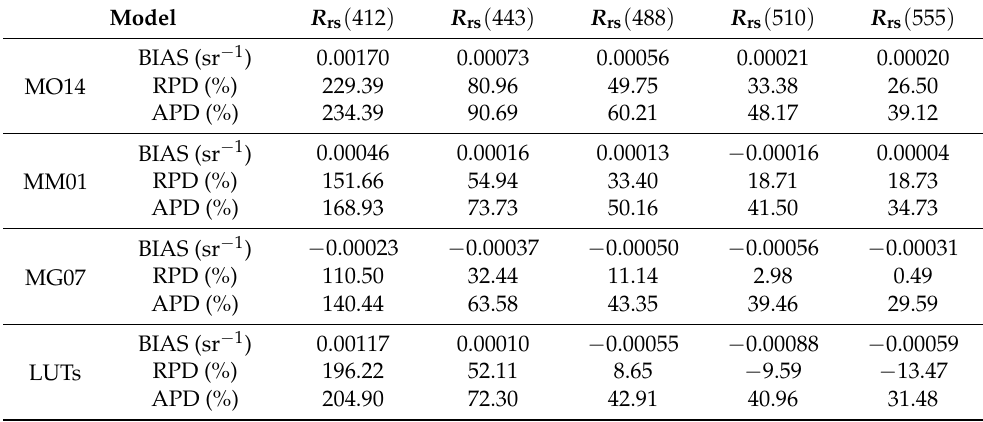
Figure A3. Performance of MM01, MG07, MO14, and LUTs models in coastal area (( a ) MO14, ( b ) MM01, ( c ) MG07, ( d ) LUTs). Table A3. Statistical parameters of MM01, MG07, MO14 and LUTs models in coastal